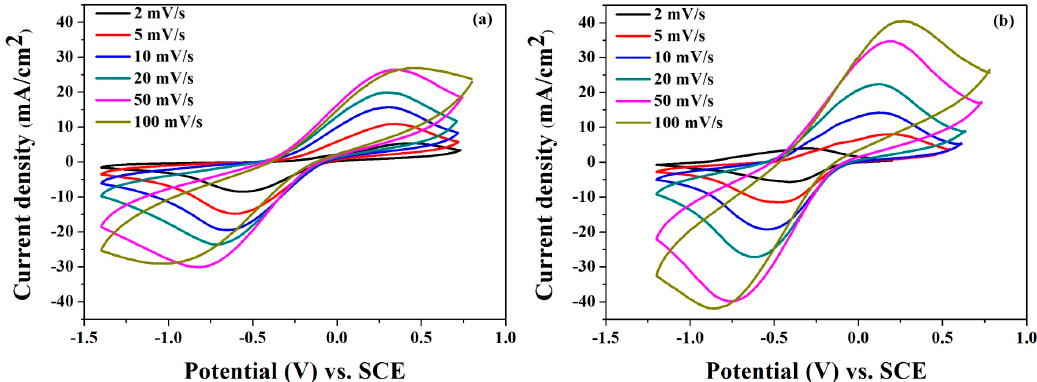
Figure 3. Cyclic voltammetry (CV) curves of ( a ) polyaniline (PANI)/GO and ( b ) PANI/M-GO composite electrodes at different scan rates in 1 M H 2 SO 4 .